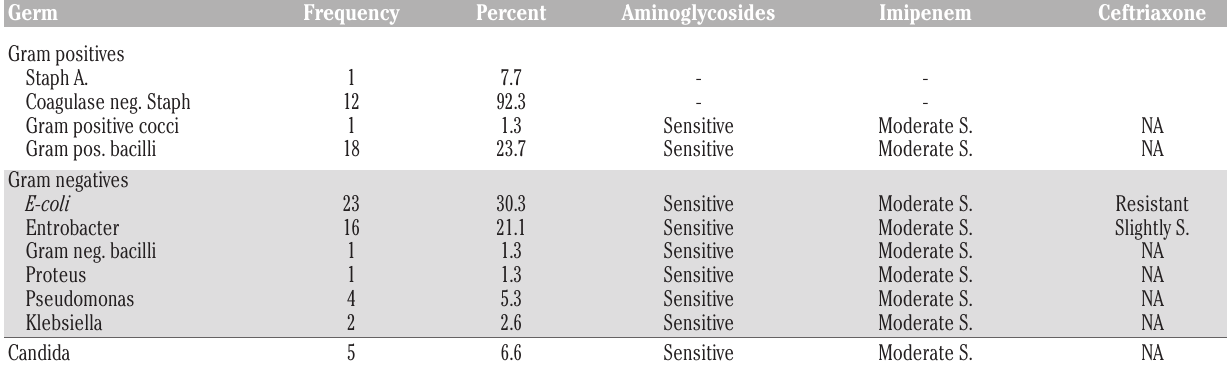
Table 2. Frequency of gram-positive, gram-negative and candida bacterial infections and their sensitivity to treatment. Germ